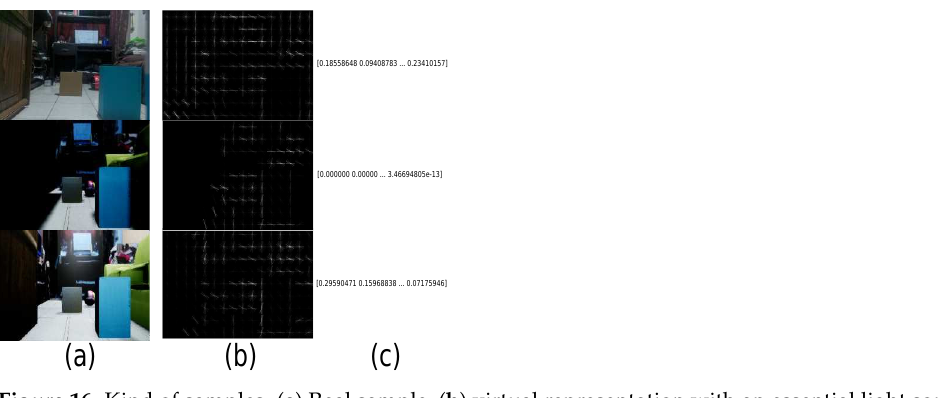
Figure 16. Kind of samples. ( a ) Real sample, ( b ) virtual representation with an essential light source, and ( c ) virtual sample with lights and materials.